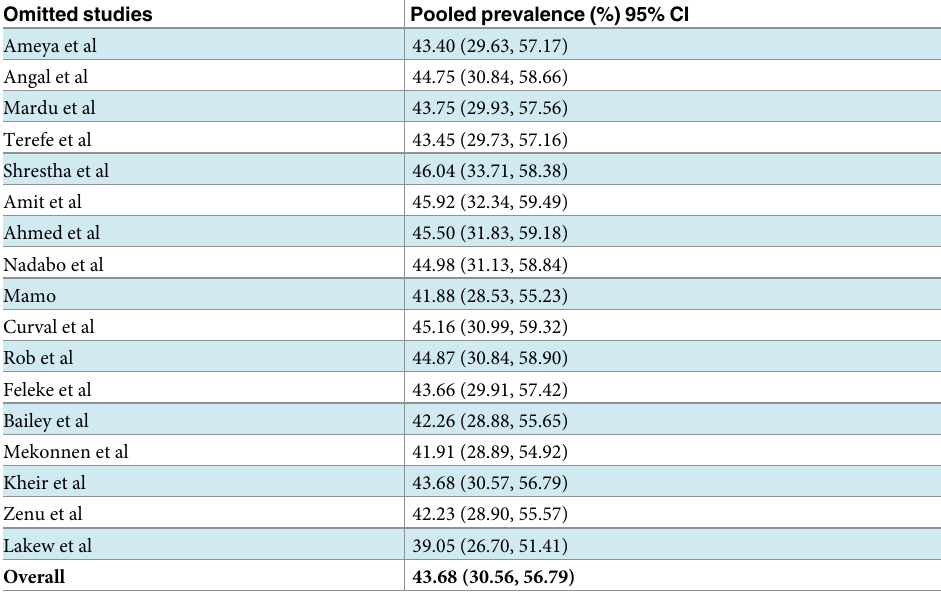
Table 4. Sensitivity analysis of intestinal parasitic infections among street dwellers and prison